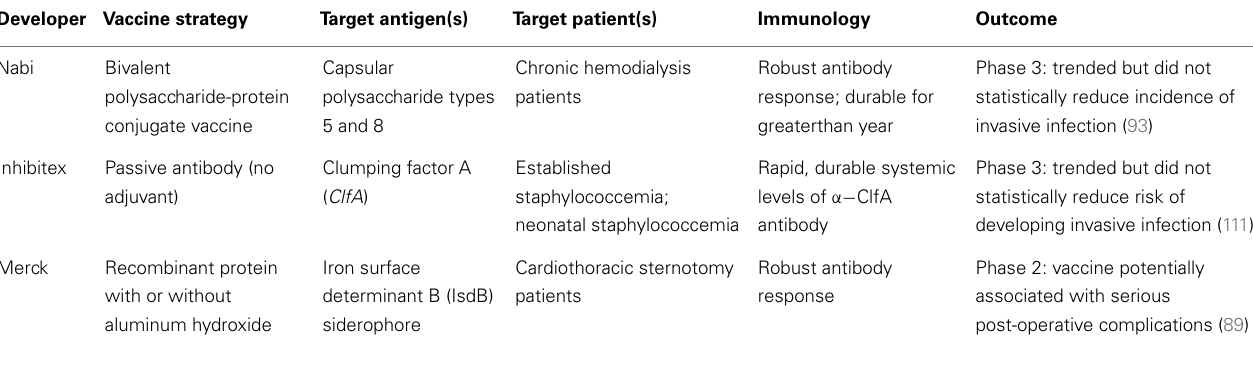
Table 3 | Comparison of recent clinical trials of active vaccines and passive antibodies targeting S. aureus disease . Developer Vaccine